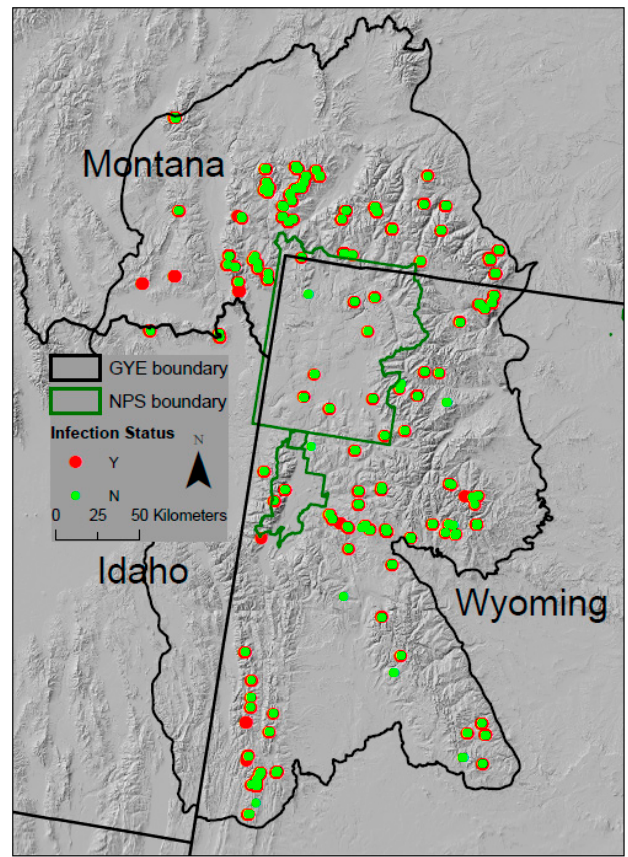
Figure 1. Location of 176 long-term monitoring transects in the Greater Yellowstone Ecosystem (GYE) and distribution of white pine blister rust infected and uninfected transects monitored between 2004 and 2018. Infection status is mapped with di ff erent sized symbols, such that overlapping points representing infected (Y) and uninfected (N) trees in the same transect can be